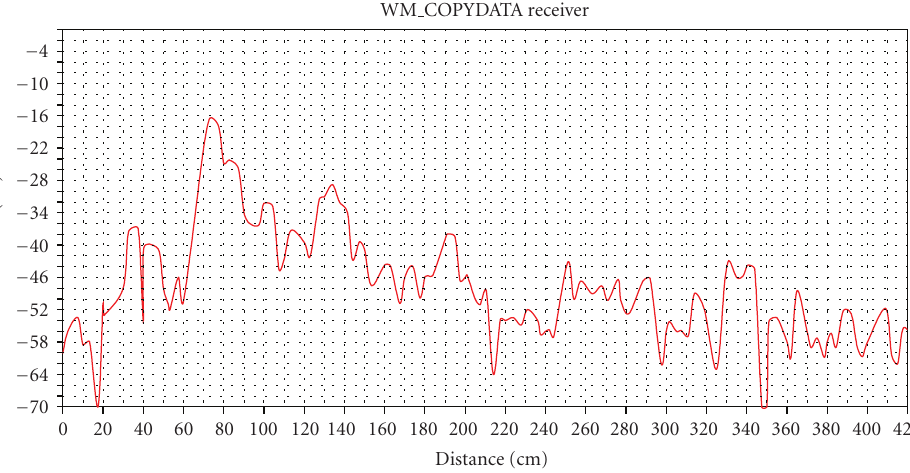
Figure 12: A scan measured with SFCW radar before calibration.